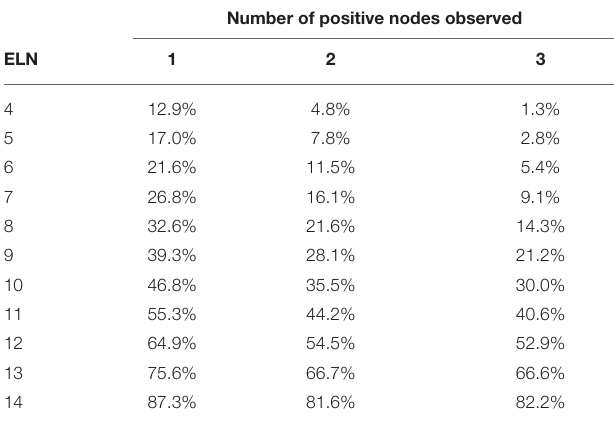
TABLE 2 | Accuracy of the number of positive lymph nodes reported according to the number of examined lymph nodes in patients with T1 tumor. Number of positive nodes observed TABLE 4 | Accuracy of the number of positive lymph nodes observed according to the number of examined lymph nodes in patients with T3